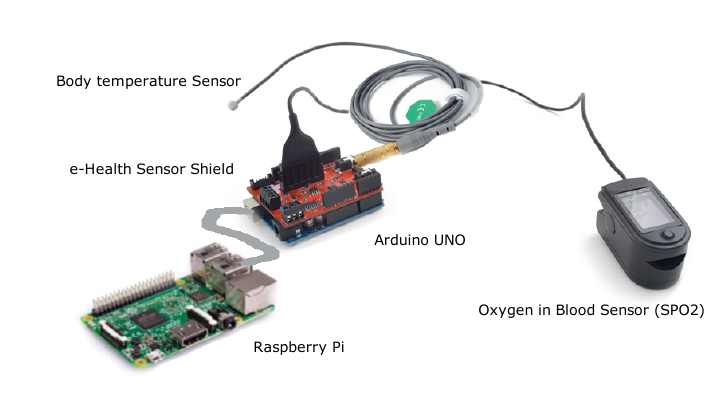
Figure 1. All the hardware components used in the